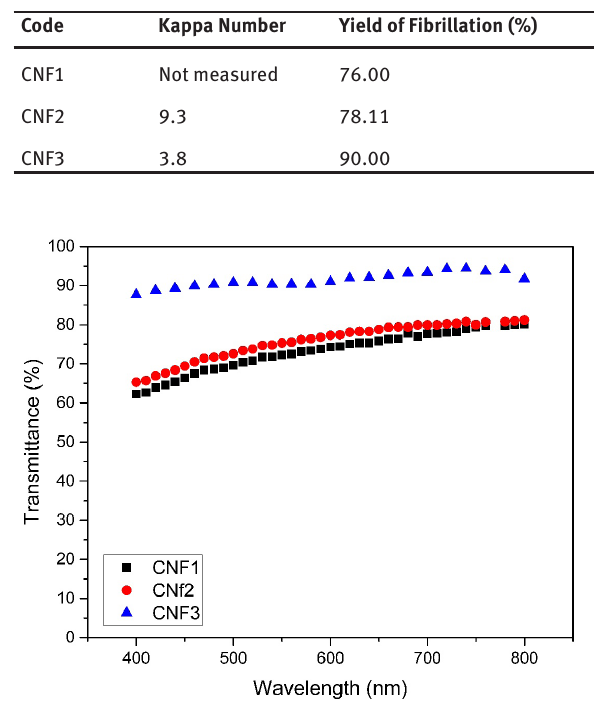
Figure 4: UV-Vis transmittance spectra of